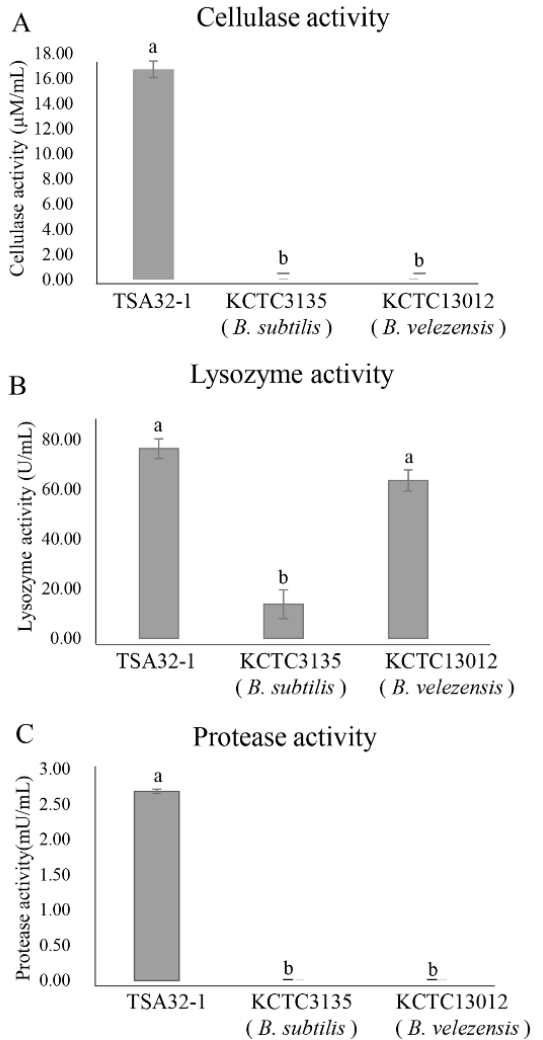
Figure 2. Enzyme activity of Bacillus spp. ( A ) Cellulase enzymes on the cell wall of TSA32-1. ( B ) Lysosomal hydrolytic enzymes on the cell wall of TSA32-1. ( C ) Protease activity of TSA32-1. Data are expressed as the means ± SD. Significant differences are marked with letters ( p < 0.05). Reference strains Bacillus subtilis KCTC3135, B. velezensis KCTC13012 were tested as controls.